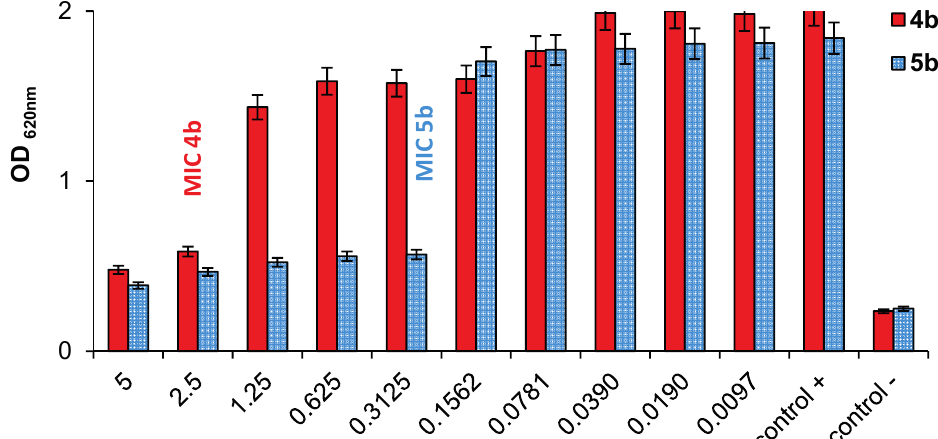
Figure 1. In vitro antibacterial activities. Minimal inhibition concentration (MIC) value of 4b and 5b against S. lutea